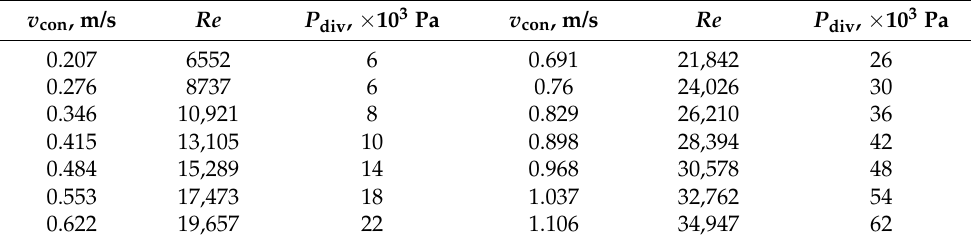
Table 4. The boundary condition value details of VT in the turbulence model selection.